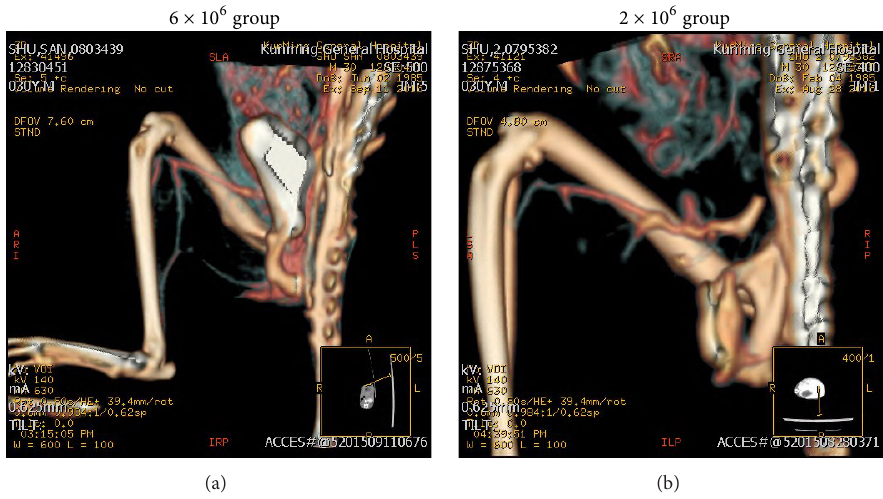
Figure 4: Angiography (arterial CTA). Angiography was performed 21 days postoperatively. (a) The injection of 6 × 10 6 UC-MSCs significantly promoted angiogenesis. (b) Injection of 2 × 10 6 UC-MSCs showed less effectiveness.